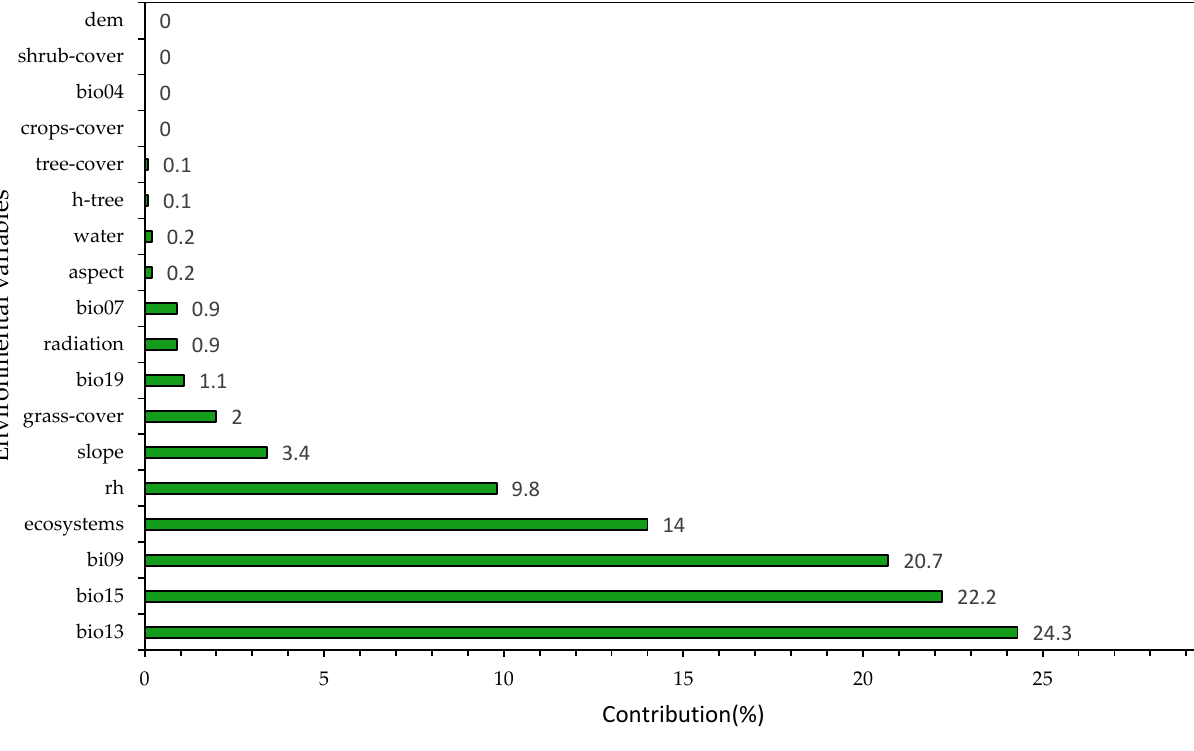
Figure 4. Contribution of environmental variables to the performance of the MaxEnt model.